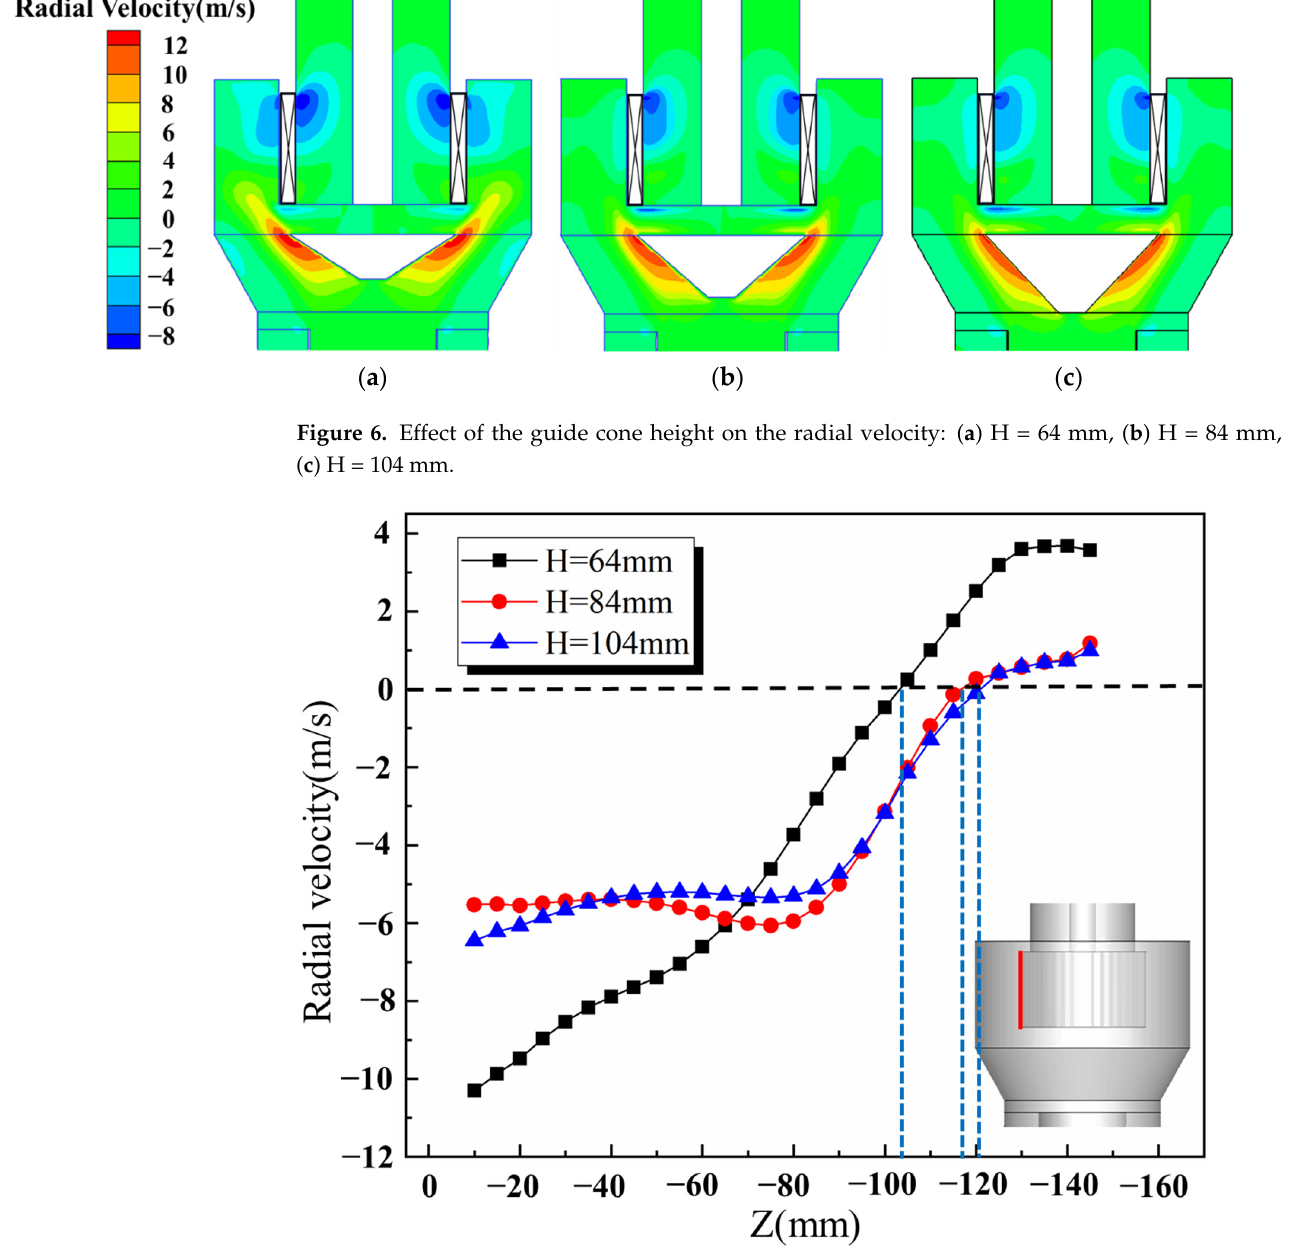
Figure 7. Effect of the guide cone height on the radial velocity of the rotor cage entrance.